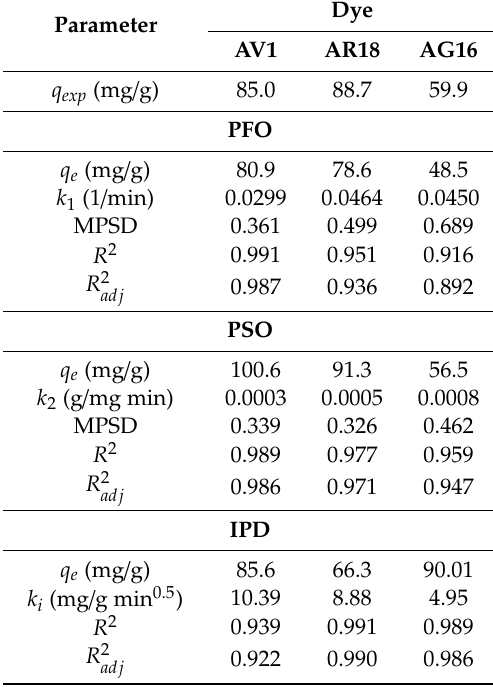
Table 5. Kinetic parameters of sorption determined in the 100 mg / L AV1 / AG16 / AR18–DVB- co -GMA- TETA